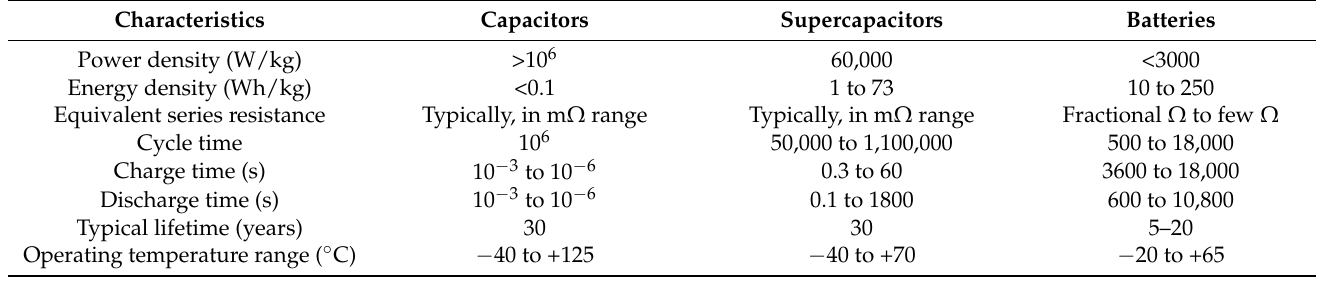
Table 1. Comparison of characteristics of supercapacitors versus batteries and conventional capaci- tors [1–3,5–10].